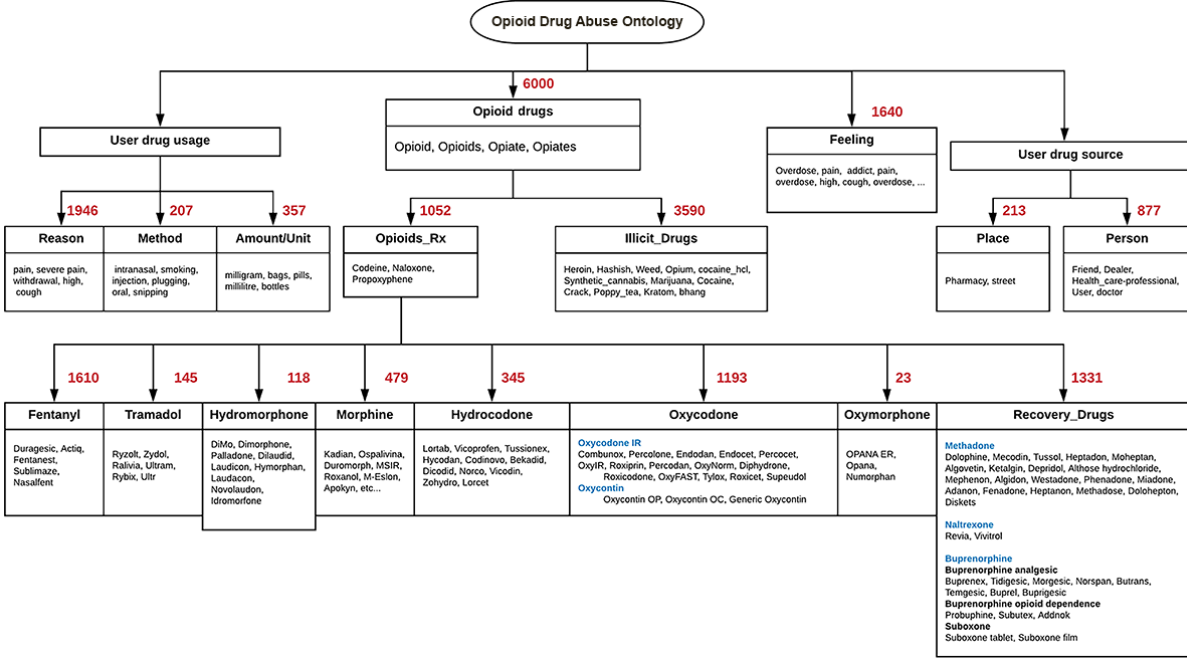
Figure 5. Opioid drug abuse ontology tree hierarchy that reflects the distribution of sample tweets over the ontology concepts and terms. Rx: